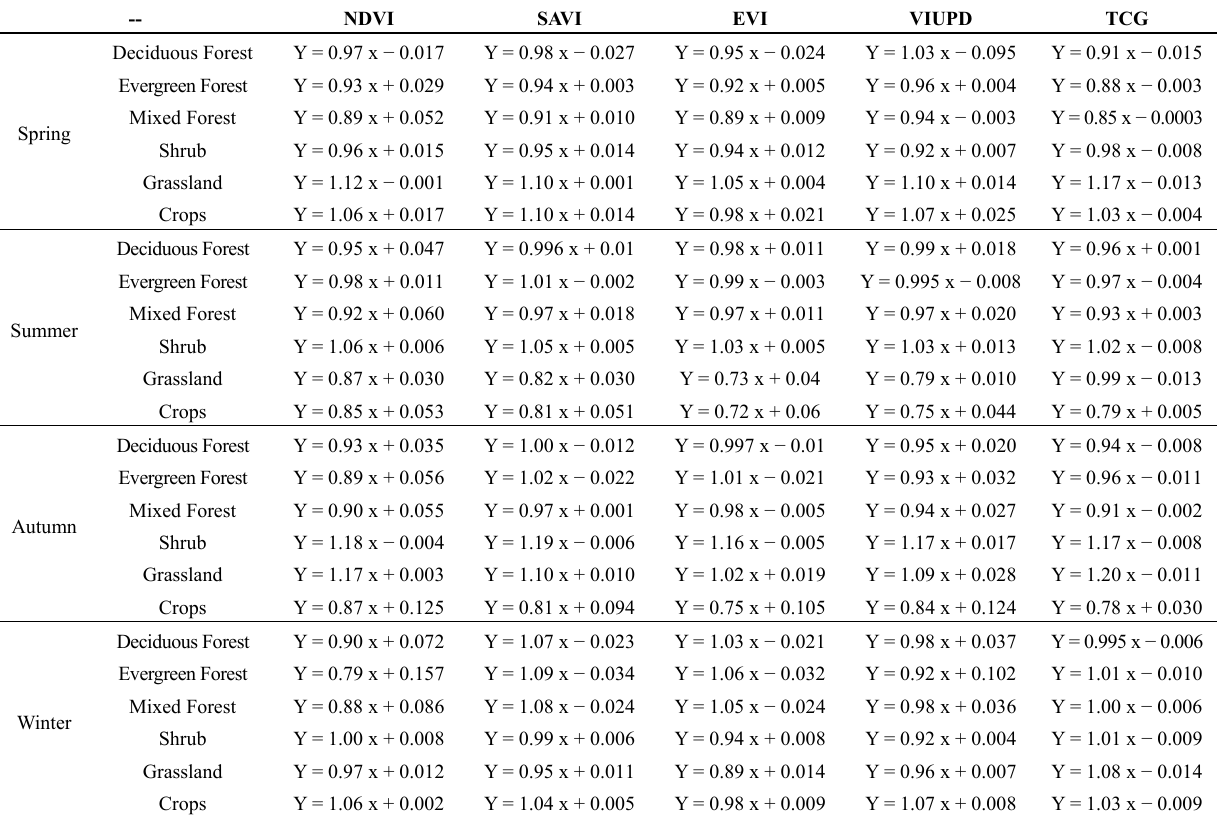
Table 3. Linear regression equations (Y = a x + b ) of the VIs derived from ETM+ and OLI data for six vegetation classes in four seasons. Y is the OLI data and x is the ETM+ data.